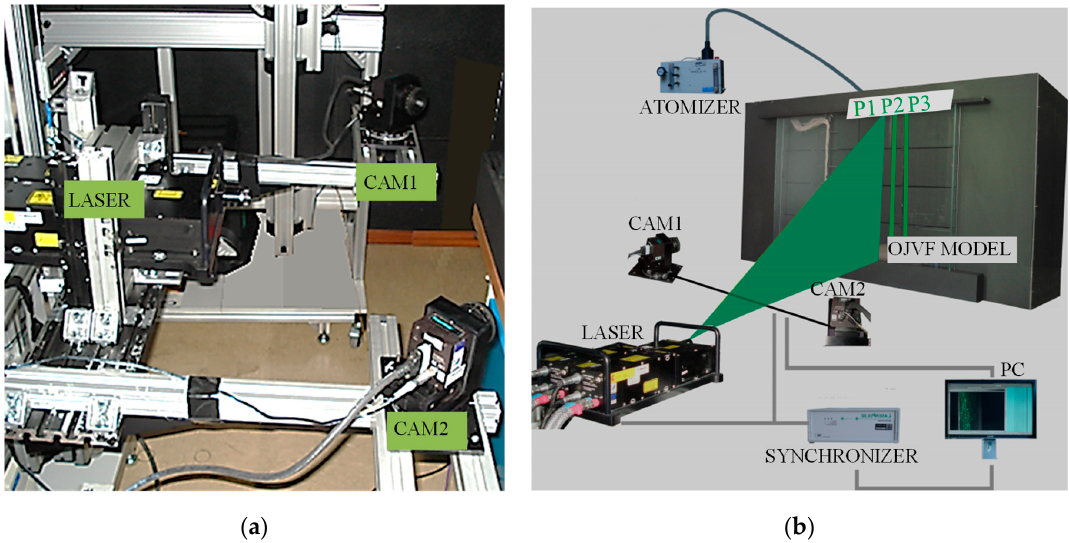
Figure 2. Experimental laser equipment for particle image velocimetry (PIV) techniques: real image ( a ) and Stereo-PIV schema ( b ).